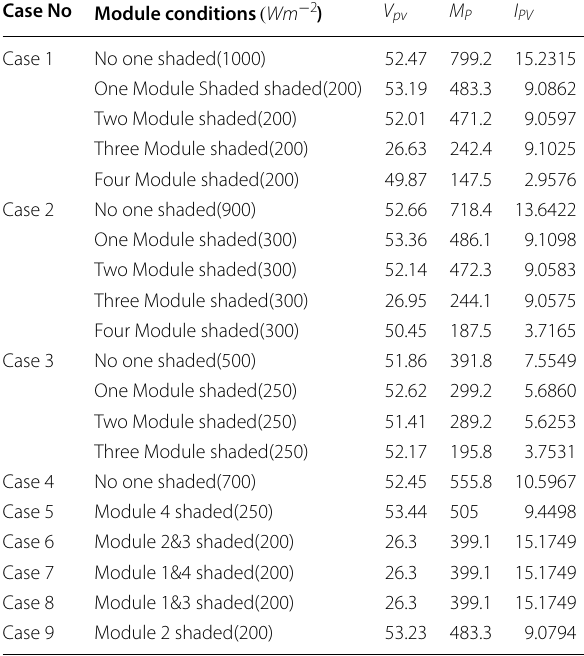
Table 1 List of cases for a 2 combinations with voltage regions